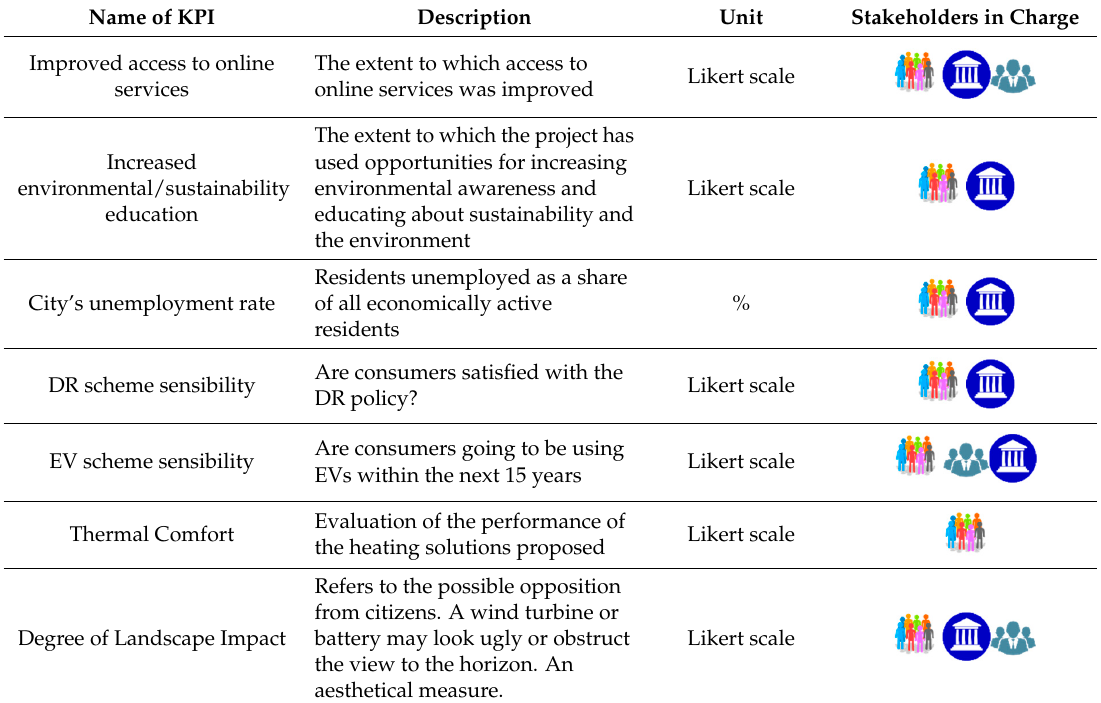
Table 7. List of Social KPIs.